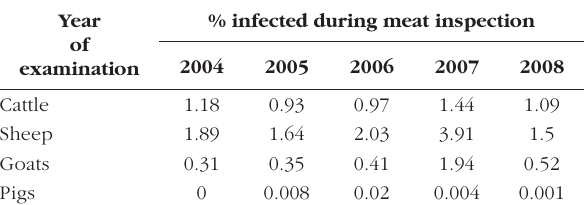
Table I. – Prevalence of Echinococcus in slaughtered